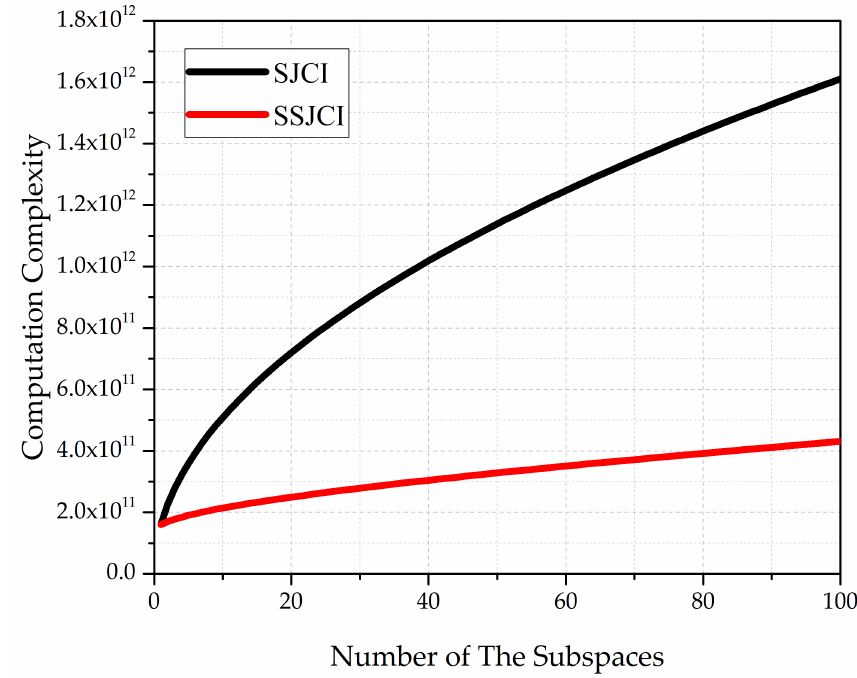
Figure 5. Computation complexity comparison between SJCI and SSJCI